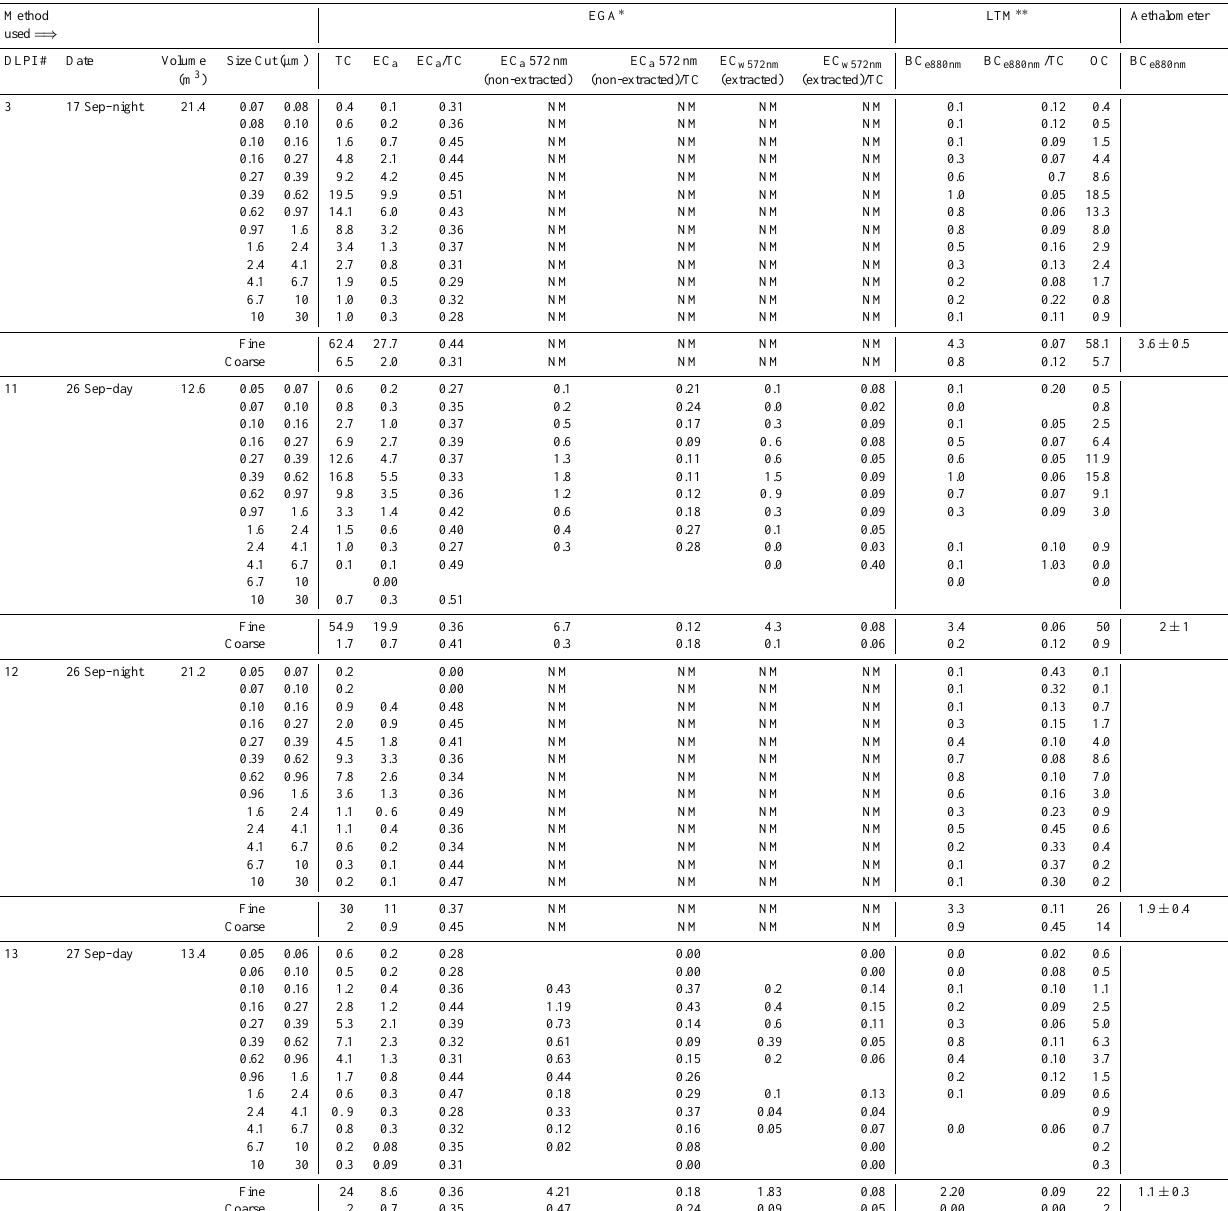
Table 1. Concentration of the size-resolved carbonaceous components collected at the pasture site (FNS) during the dry period for the LBA- SMOCC-2002 campaign using different methods (EGA, LTM and aethalometer). All concentrations are given in µgm − 3 . NM indicates not measured and STDEV refers to the standard deviaton of the average. The last column is for the equivalent black carbon (BC e ) for particles with D p < 10µm measured by the aethalometer at 880nm and corrected for the filter loading and multiple scattering artifacts. EGA